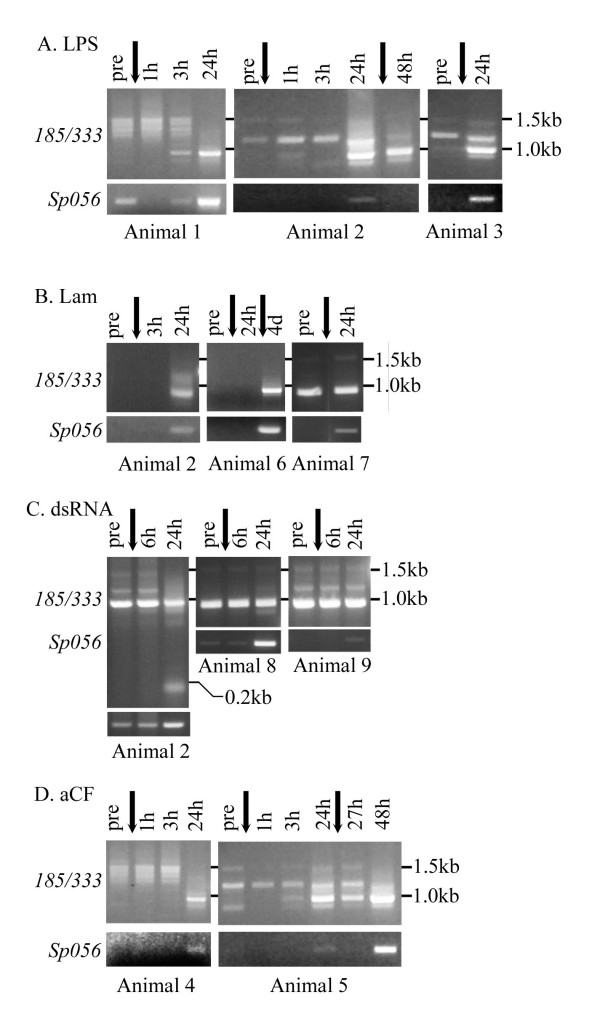
Expression of 185/333 in response to various antigens. Nine animals were injected with either (A) LPS (n = 3), (B) Lam (n = 3), (C) dsRNA (n = 3), or (D) aCF (n = 2). Whole coelomic fluid (wCF) samples were collected prior to injection (pre) and at various times after challenge. The expression of both 185/333 (upper gels) and Sp056 (lower gels) were analyzed by RT-PCR in separate reactions and the agarose gels are shown. The vertical arrows indicate the time points at which the animals received injection(s). All animals received at least one injection at 0 h. Based on immune activation responses, three animals received second injections; animal 2-LPS and animal 5 at 24 h, animal 6 at 72 h.